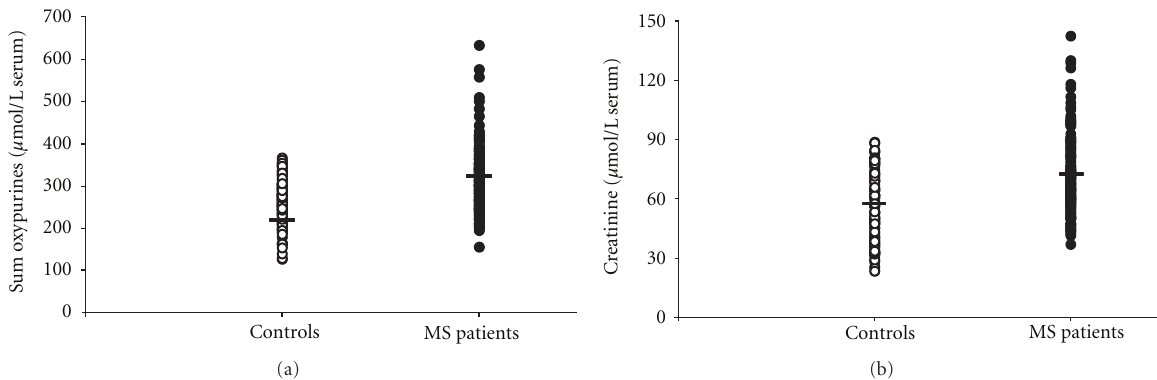
Figure 1: Scatter plot showing the sum of oxypurines (uric acid + hypoxanthine + xanthine) (a) and creatinine (b) recorded in serum of 163 healthy controls and 170 MS patients. Horizontal bars indicate the mean values calculated in the two groups.